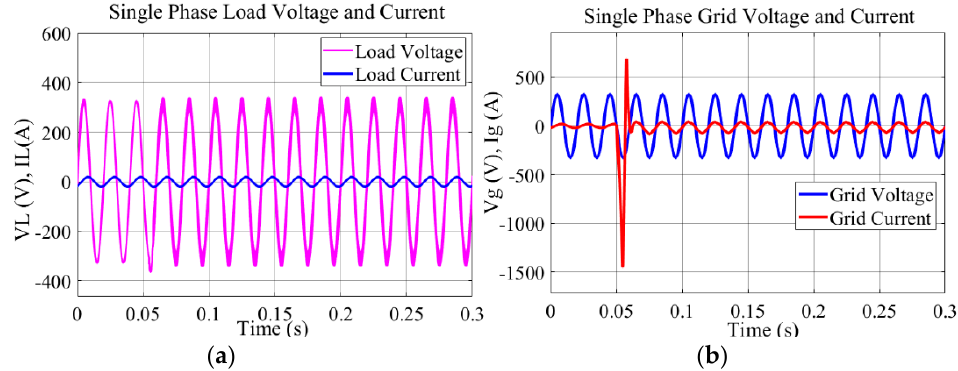
( b ) Figure 12. ( a ) DC bus voltage. ( b ) Active and reactive power. 6.3.2. Scenario 2: NL load With a three-phase uncontrollable AC-DC converter and the parameters L = 0.1 H, C = 600 µF, and R = 15 Ω , HMG’s performance is seen in this circumstance as a non-linear load. Harmonics are introduced to the load on the source side while integrating the non- linear load. Figure 13 illustrates the simulated response of the load current and load voltage for a non-linear load. The slight increase in voltage can be seen at 0.05 s in Figure 13a. The HMG is then added after 0.05 s. The estimated BAC kept stability. Figure 13b shows how the load current’s performance changes when harmonics are introduced into the grid. Fig- ure 14a displays the phase voltage and current on the load side. It demonstrates that even after connecting the HMG, the phase voltage and current remain in synchronism. The introduction of harmonics causes a tiny variation in the grid current’s current form. Figure 14b displays the voltage and current response for the single-phase grid. It suggests that while connecting the HMG at 0.05 s, the grid current is not kept in synchrony. The